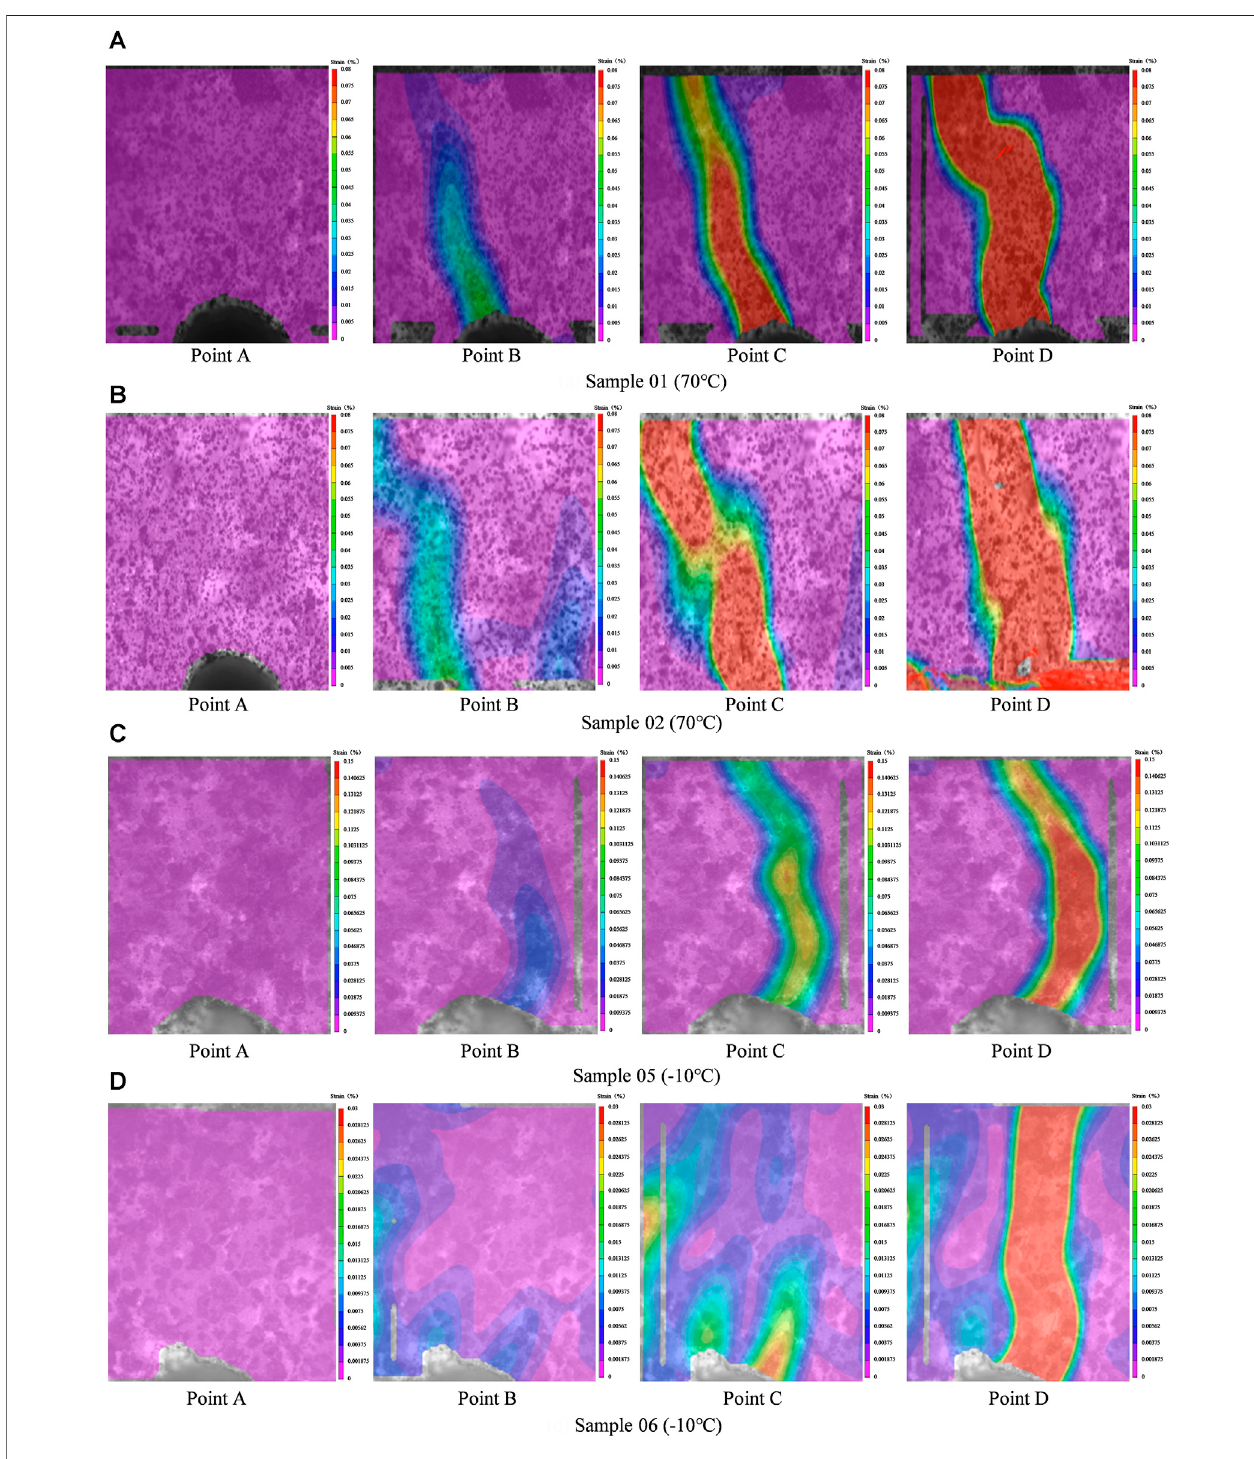
FIGURE 7 | Evolution of the maximum principal strain fi eld ahead of a notch tip at different temperatures ( A – D correspond to the starting point of the load – displacement curve, a certain point during the elastic stage, the peak load point, and the point at which the load began to decrease rapidly, respectively).